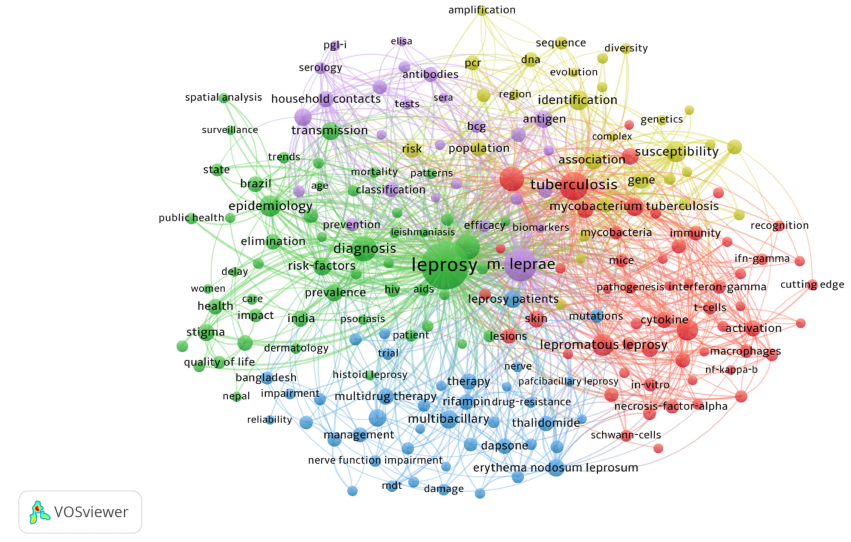
Figure 6. Keyword co-occurrence network about the field of leprosy